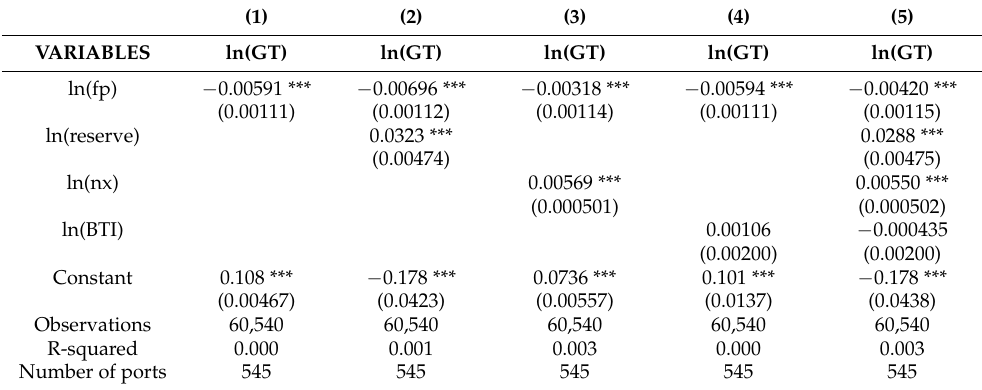
Table 5. Results of fixed-effect regression (GT).